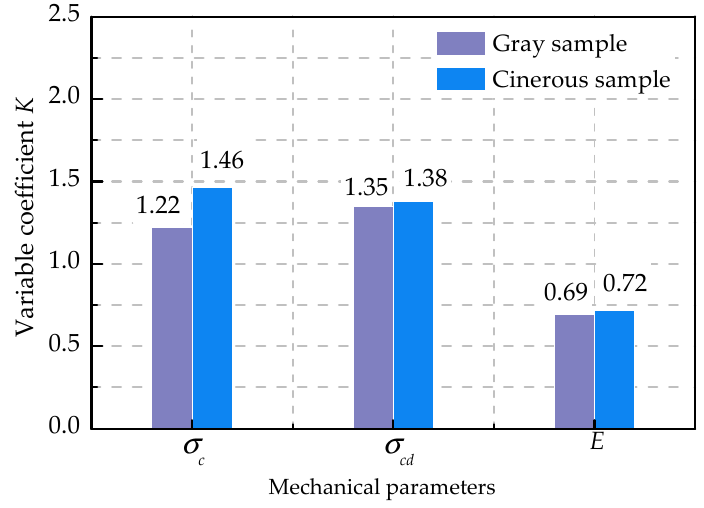
Figure 6. Variation coefficients of slate samples. Analysis of the slate structural features shows that there are differences in the ap- pearance and morphology of slate samples. Gray slate alternates with being gray and white, with a good filling and adhesive bonding in the bedding. The appearance of car- bonaceous slate is uniform in color, but the slate structure is weak. The structural surface has muddy fillings, and the distribution of mineral composition and original fractures are quite different, showing complex fracture modes and uneven fracture morphology at the macro level. The superimposed structural characteristics of slate samples show that the discrete characteristics of mechanical parameters are also related to the distribution characteristics of macroscopic joints. The directionality of the cleat system restricts the anisotropy of the mechanical properties. Different stress loading directions and complex bedding superimposed structures are the external and internal reasons for the variability of slate mechanical